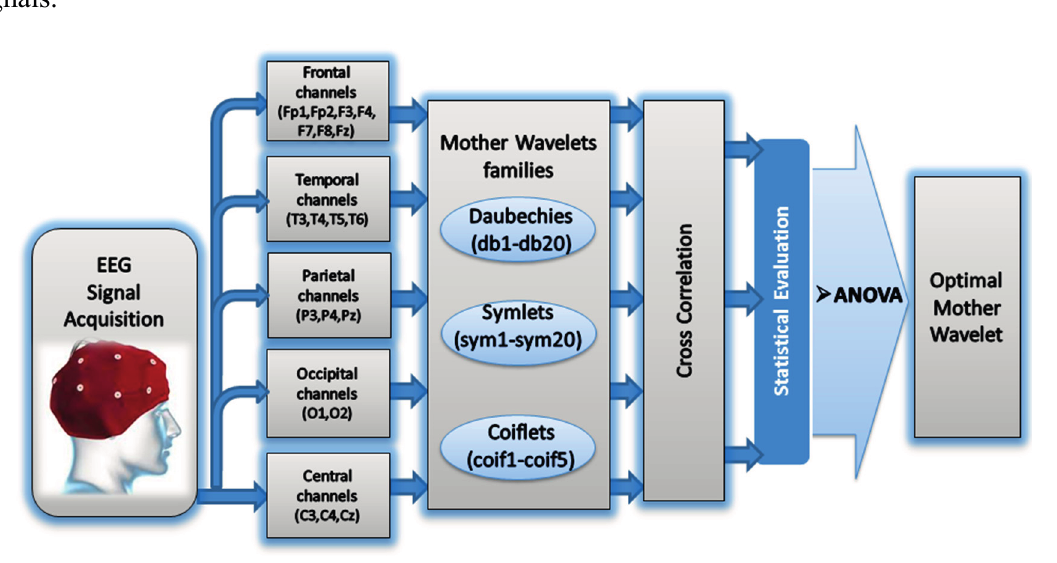
Figure 1. The block diagram of the proposed